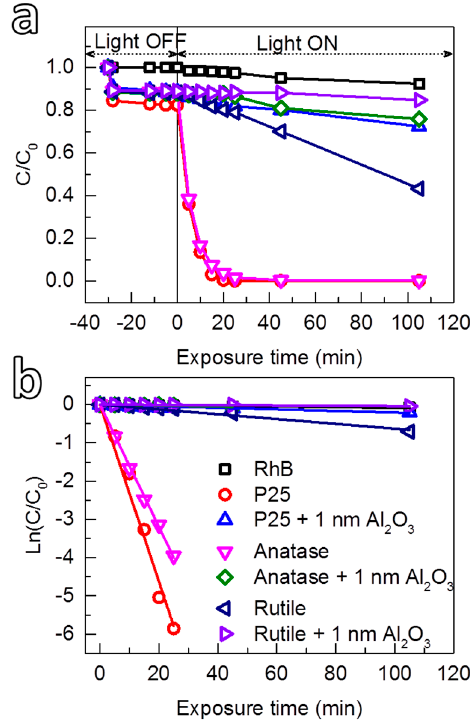
Figure 7. ( a ) Photodegradation as a function of exposure time of RhB solution by uncoated TiO 2 (P25, anatase and rutile) and the TiO 2 coated with 1 nm Al 2 O 3 , and ( b ) the corresponding kinetic plots. All of the photocatalytic tests were carried out under identical experimental conditions. The self-degradation of RhB is added as the reference.